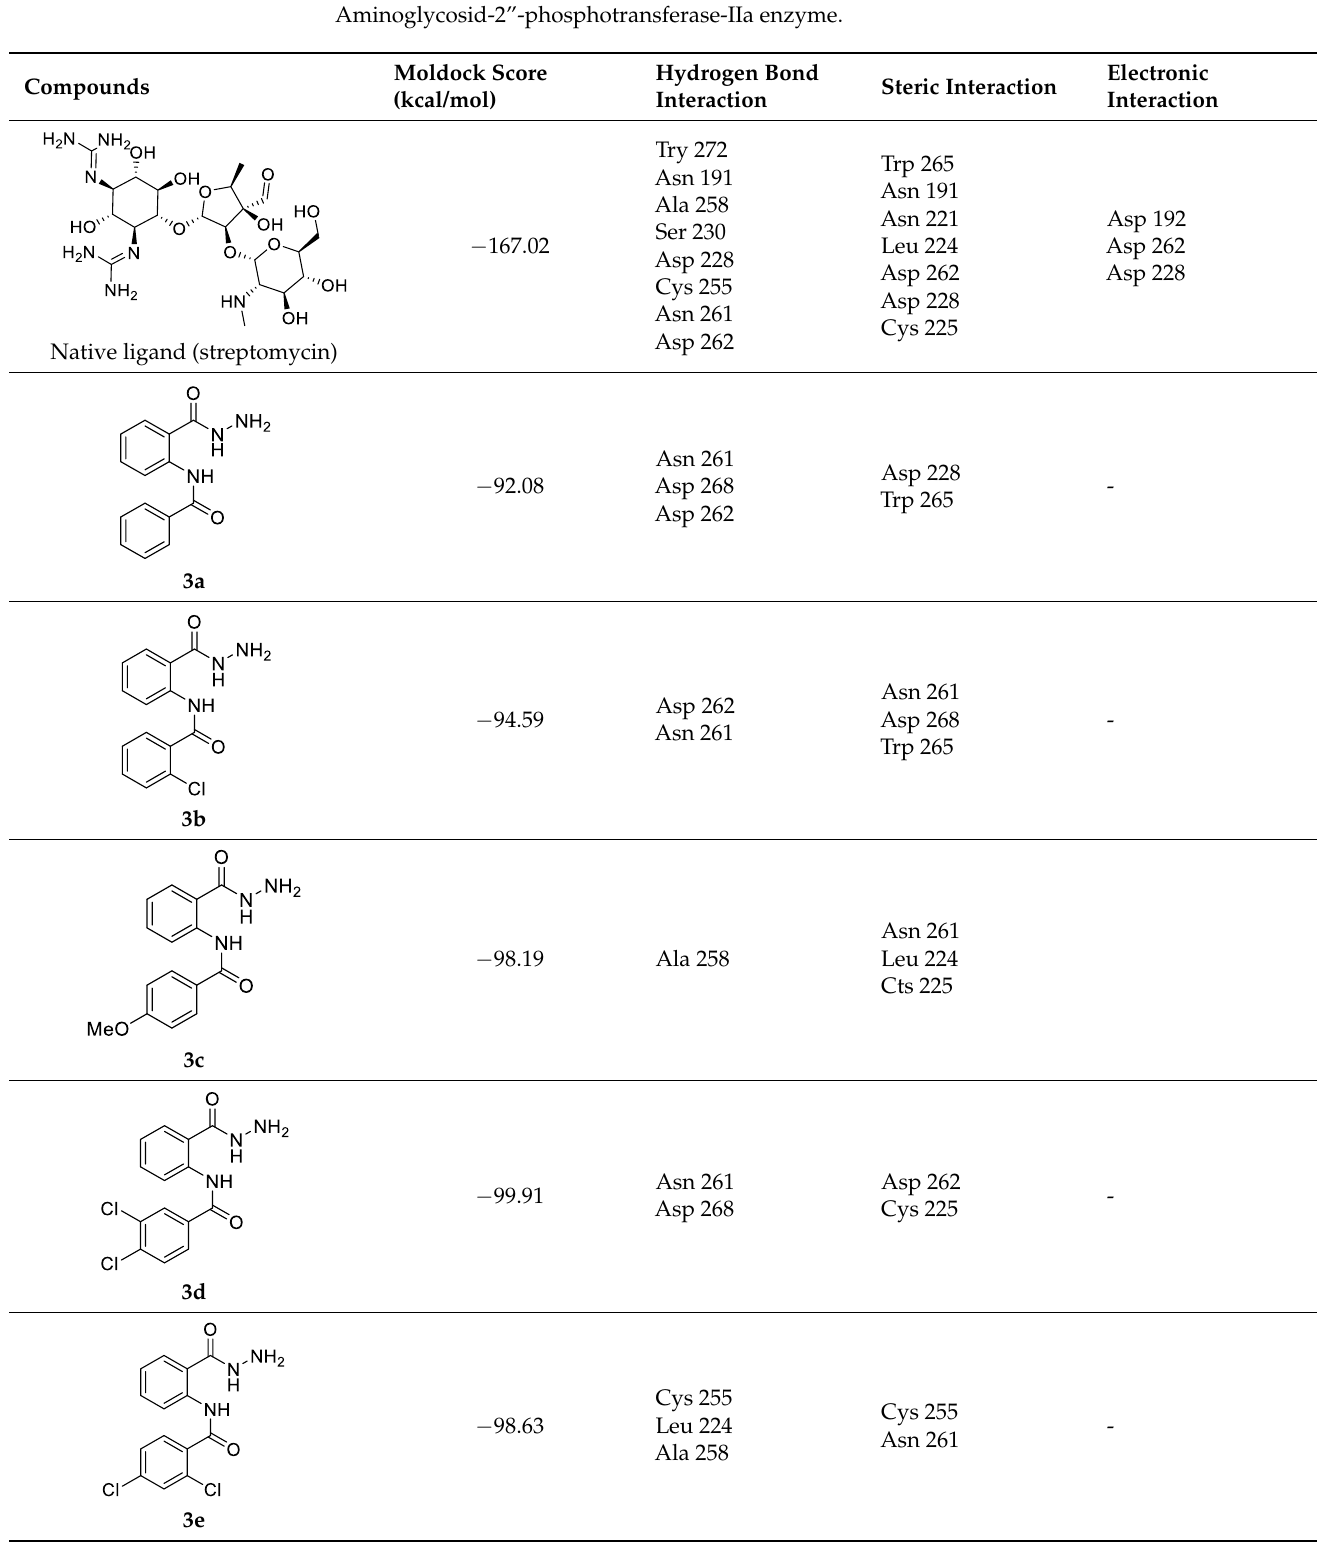
Table 2. The Molecular docking result of Streptomycin and compounds 3a – e into active site Aminoglycosid-2 ’’ -phosphotransferase-IIa enzyme.